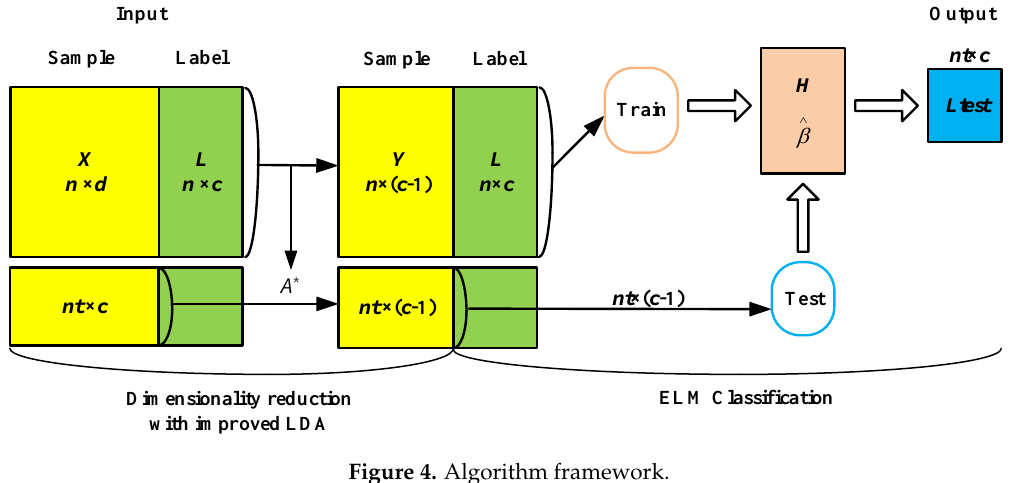
Figure 4. Algorithm